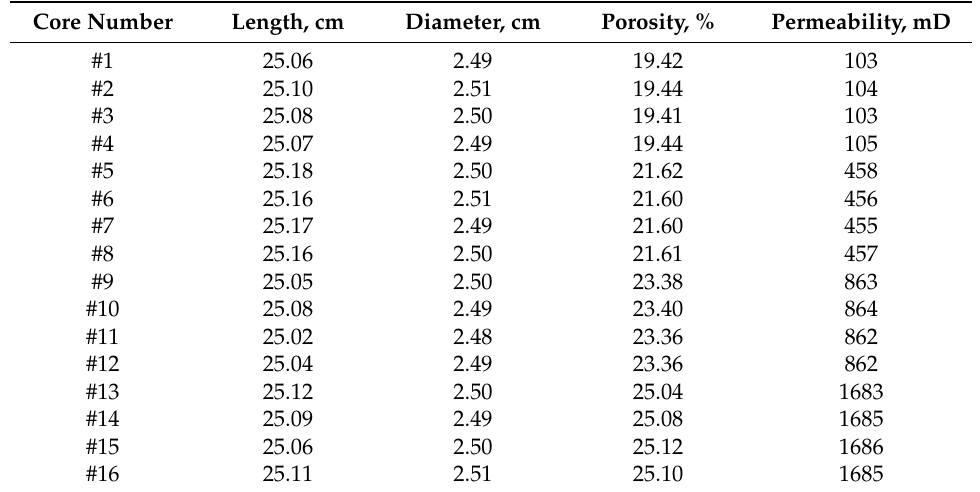
Table 4. Parameters of core samples used to study the relationship between TPG and mobility.